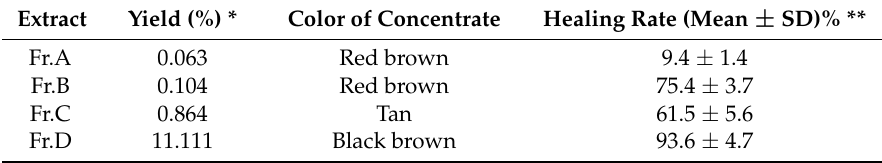
Table 1. The yield, color and healing rate of different solvent extracts (Fr.A: chloroform fraction; Fr.B: ethyl acetate fraction; Fr.C: n -butanol fraction; Fr.D: water fraction D) of 500 mL of Periplaneta Americana (PA) ethanol